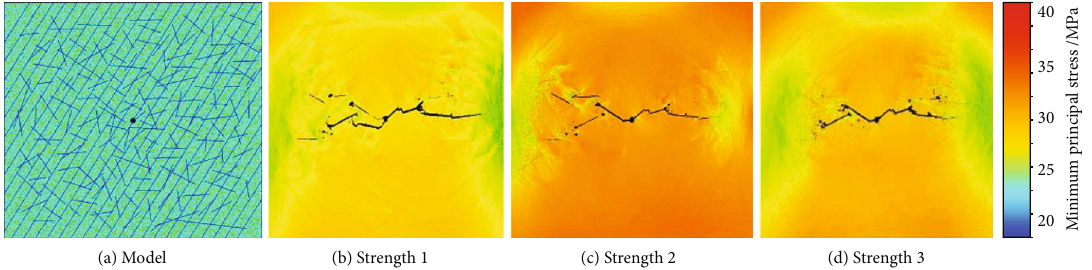
Figure 19: Fracture propagation with bedding plane and natural fractures [55]. Table 4: Strength parameters of natural fractures.